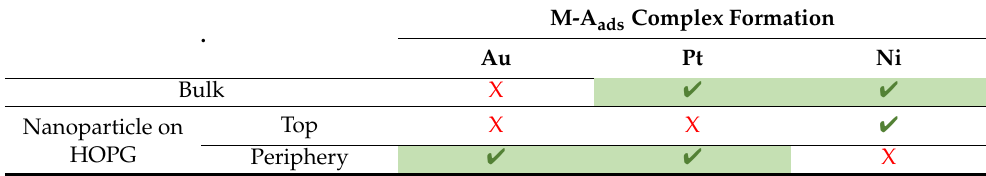
Table 1. Formation of the M-A ads complex on the surface of bulk and nanostructured gold, platinum, and nickel. Differences in the adsorption properties for the upper and peripheral regions are shown for nanoparticles. Stable adsorption complex is marked with green tick, unstable—with red cross. Similarities in adsorption properties for different systems are shown with green